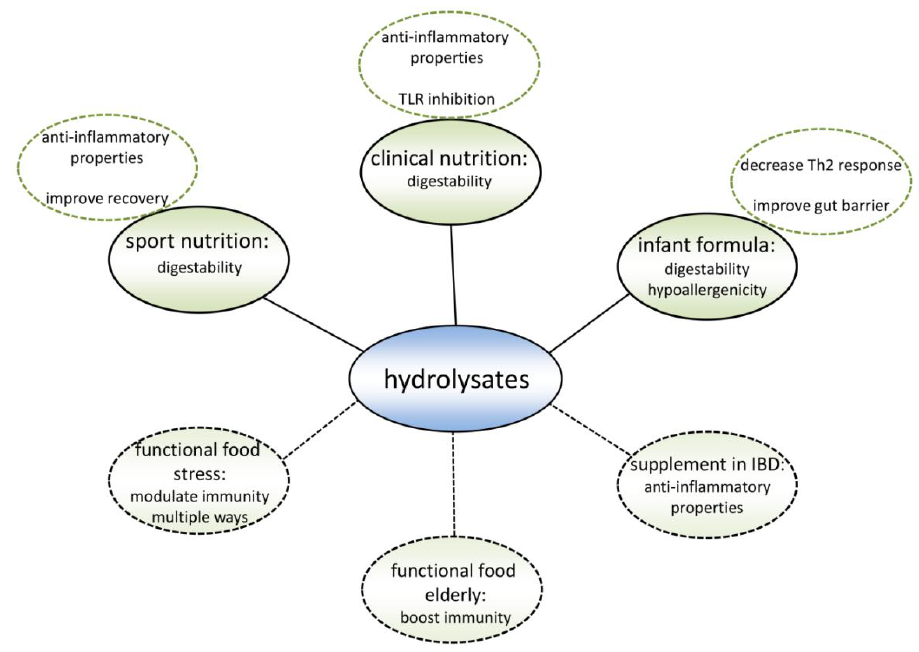
Figure 4. Summary of the application possibilities of protein hydrolysates. These hydrolysates are currently being used in sport nutrition, clinical nutrition, and infant formula, mainly because of their good digestibility and hypoallergenicity. Recent research indicates that specific protein hydrolysates could optimize the current products in multiple ways. Also, there is evidence that new protein hydrolysate products could be beneficial for specific target groups.